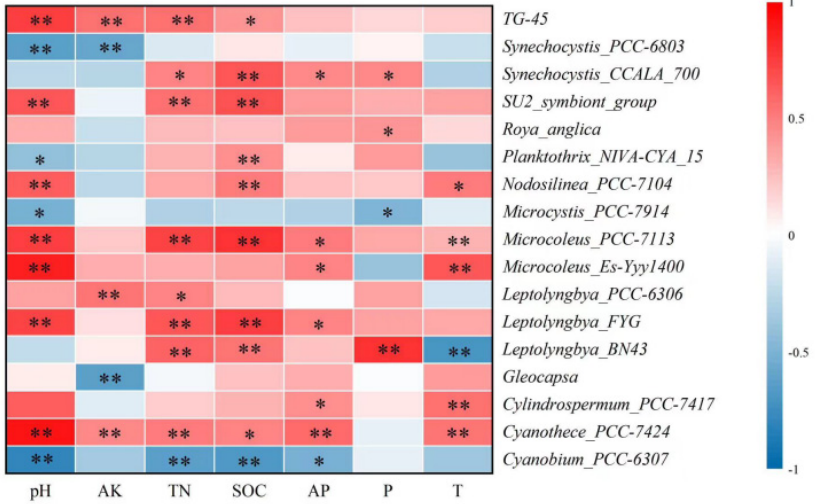
Figure 6. Correlation heatmap between the cyanobacterial genus and soil nutrients Note: * ( p < 0.05) ** ( p < 0.01).